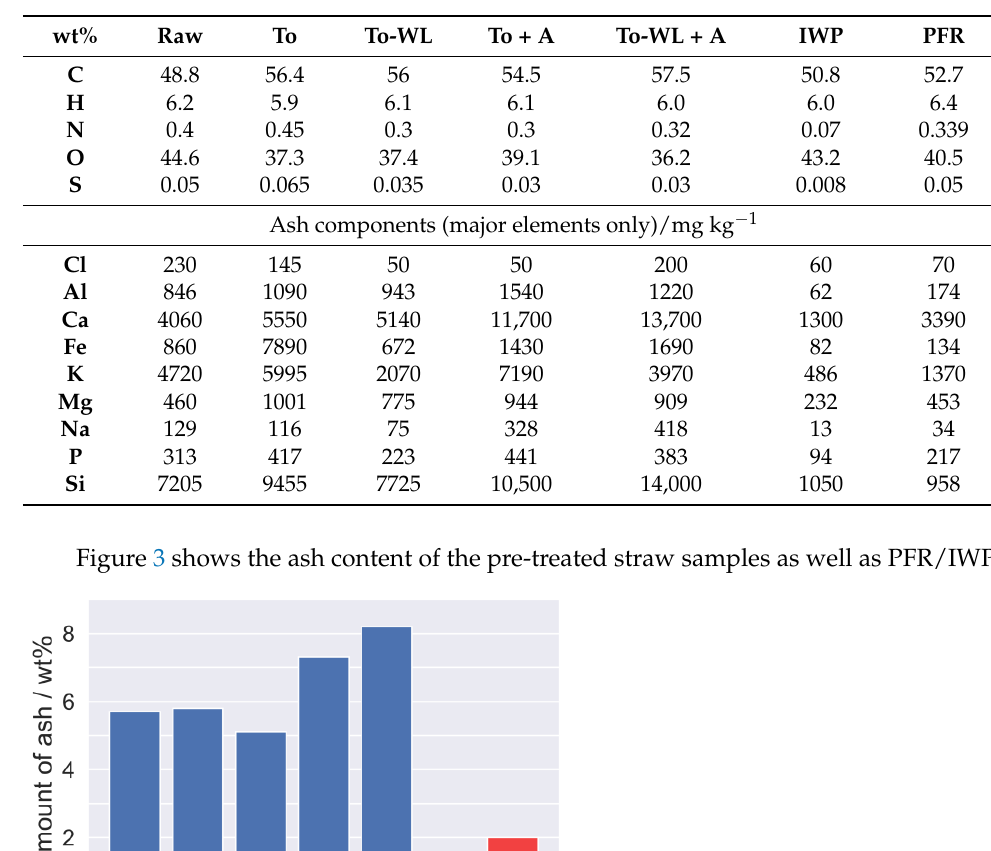
Table 2. Chemical composition of the pre-treated wheat straw samples as well as the benchmark materials. The actual contents in each fuel sample are presented on a dry solid basis. O was calculated by difference. To: torrefied, To-WL: torrefied/water-leached, To + A: torrefied plus 2 wt% CaCO 3 , To-WL + A: torrefied/water-leached plus 2 wt% CaCO 3 , IWP: industrial wood pellets and PFR: pine forest residues.